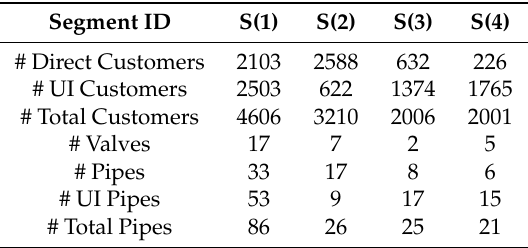
Table 10. Analysis results for large-scale